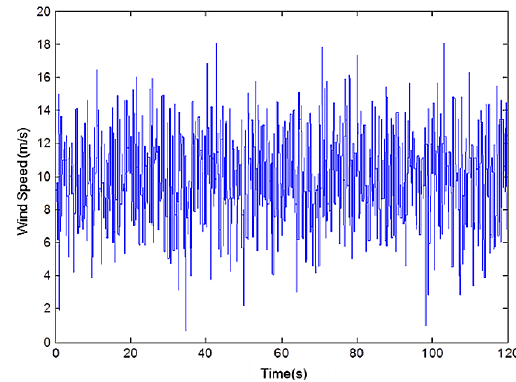
Figure 11. Applied wind speed profile. Table 2. Thermal parameters extracted from the finite element model (FEM).